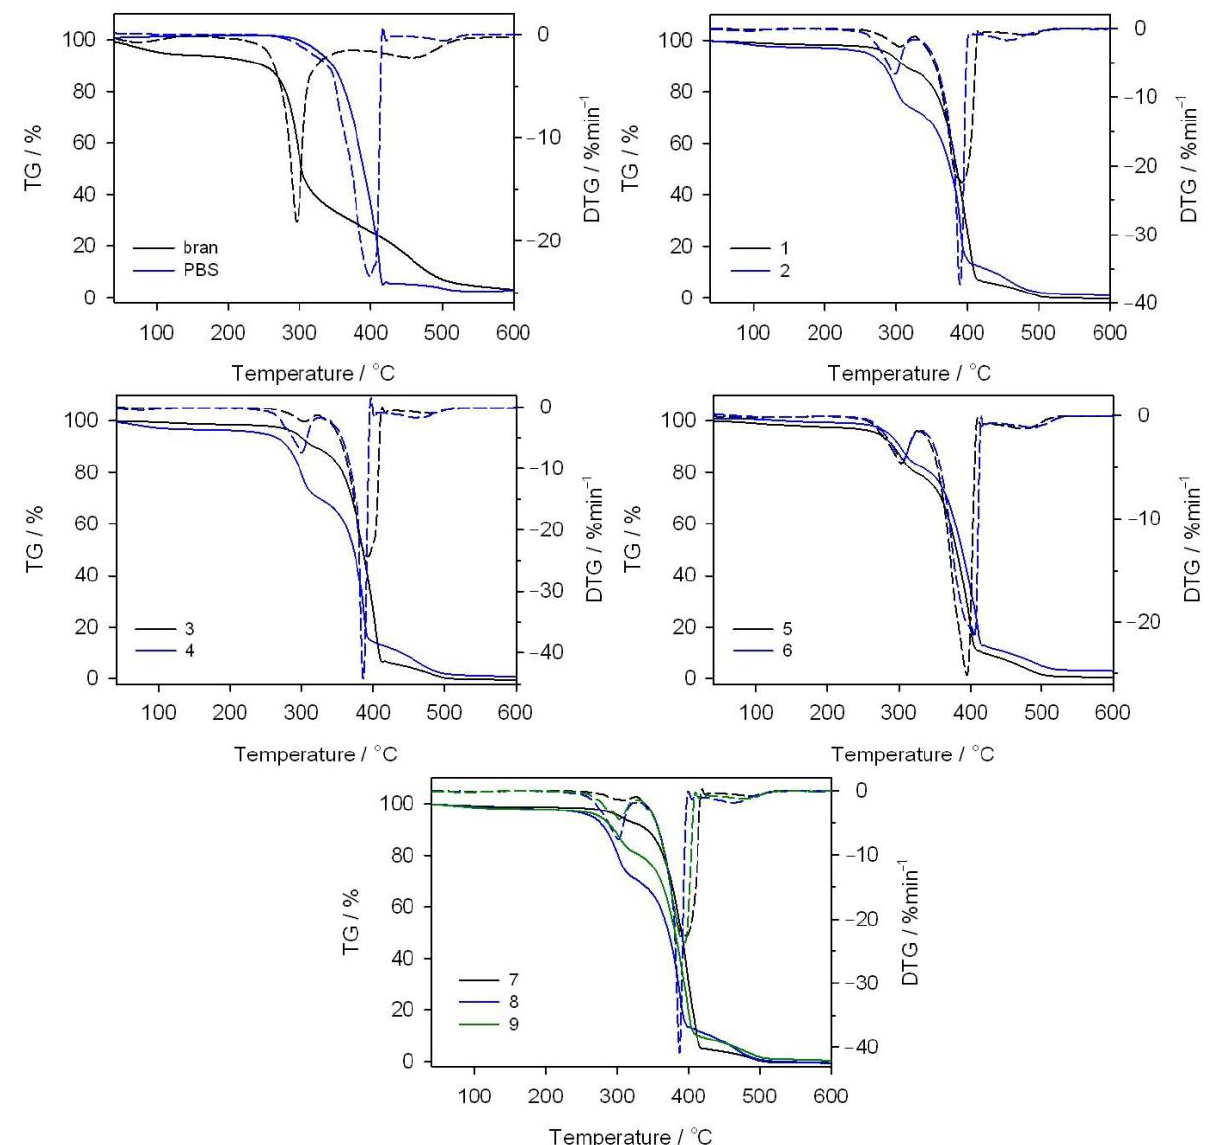
Figure 14. TG and DTG curves obtained in an oxidizing atmosphere for bran, PBS and their composites.